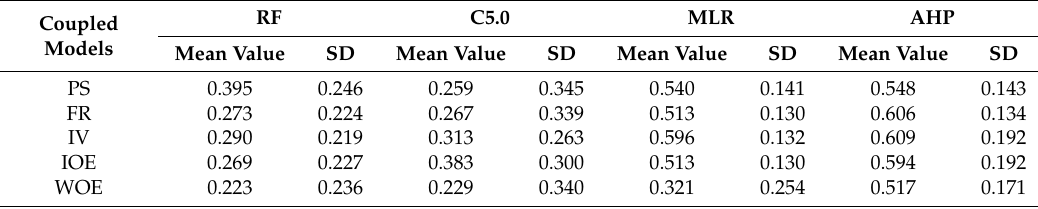
Figure 11. Collapse susceptibility indexes distribution of PS-RF ( a ), FR-RF ( b ), IV-RF( c ), IOE-RF ( d ) and WOE-RF ( e ). Table 5. Mean and standard deviation of different connection methods under different data-based models.